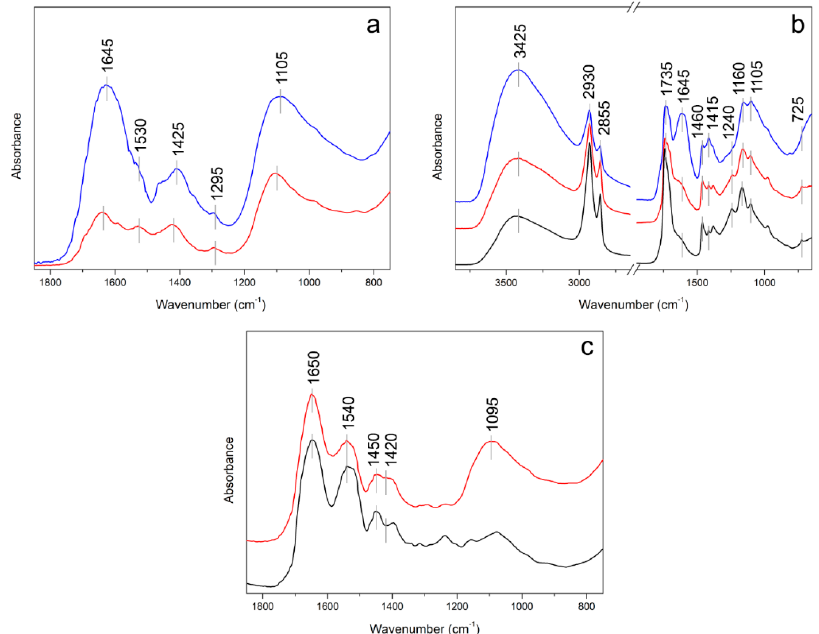
Figure 8. μ FTIR-transmission analyses performed on some micro-samples: ( a ) ML grains at t = 0 (red) and t = 520 h (blue); ( b ) OCV without ML at t = 0 h (black), ML embedded in the OCV at t = 0 h (red) and at t = 520 h (blue); ( c ) AC at t = 0 h (black) and ML grain embedded in AC at t = 0 h (red).